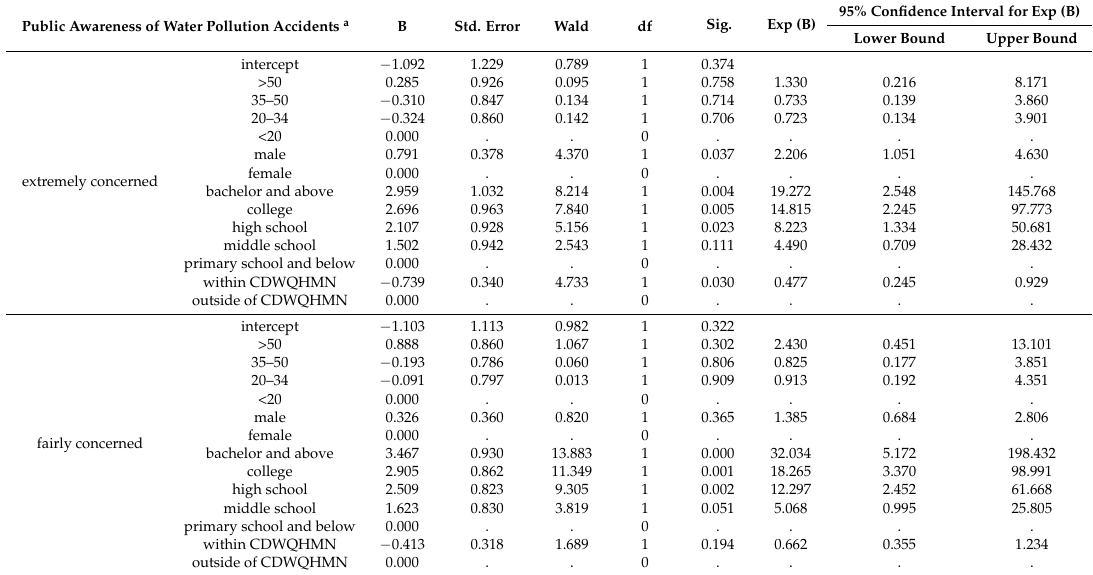
Table 6. Results of multinomial logistic regression analysis for public awareness of water pollution accidents and influencing